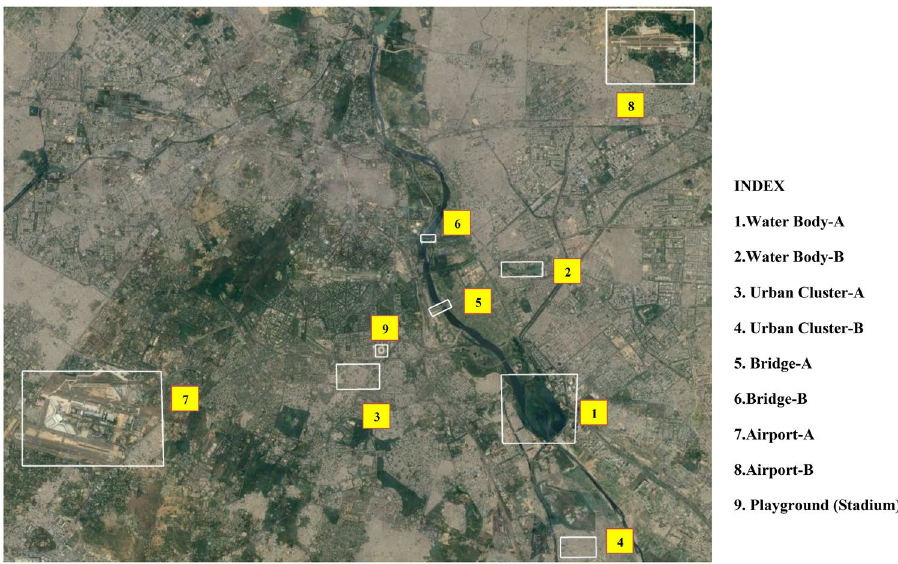
Figure 23. A detailed location of the sample site. Exhibits the sample selected locations for the detailed study of the urban features with the help of dual-polarised C-band SAR datasets.